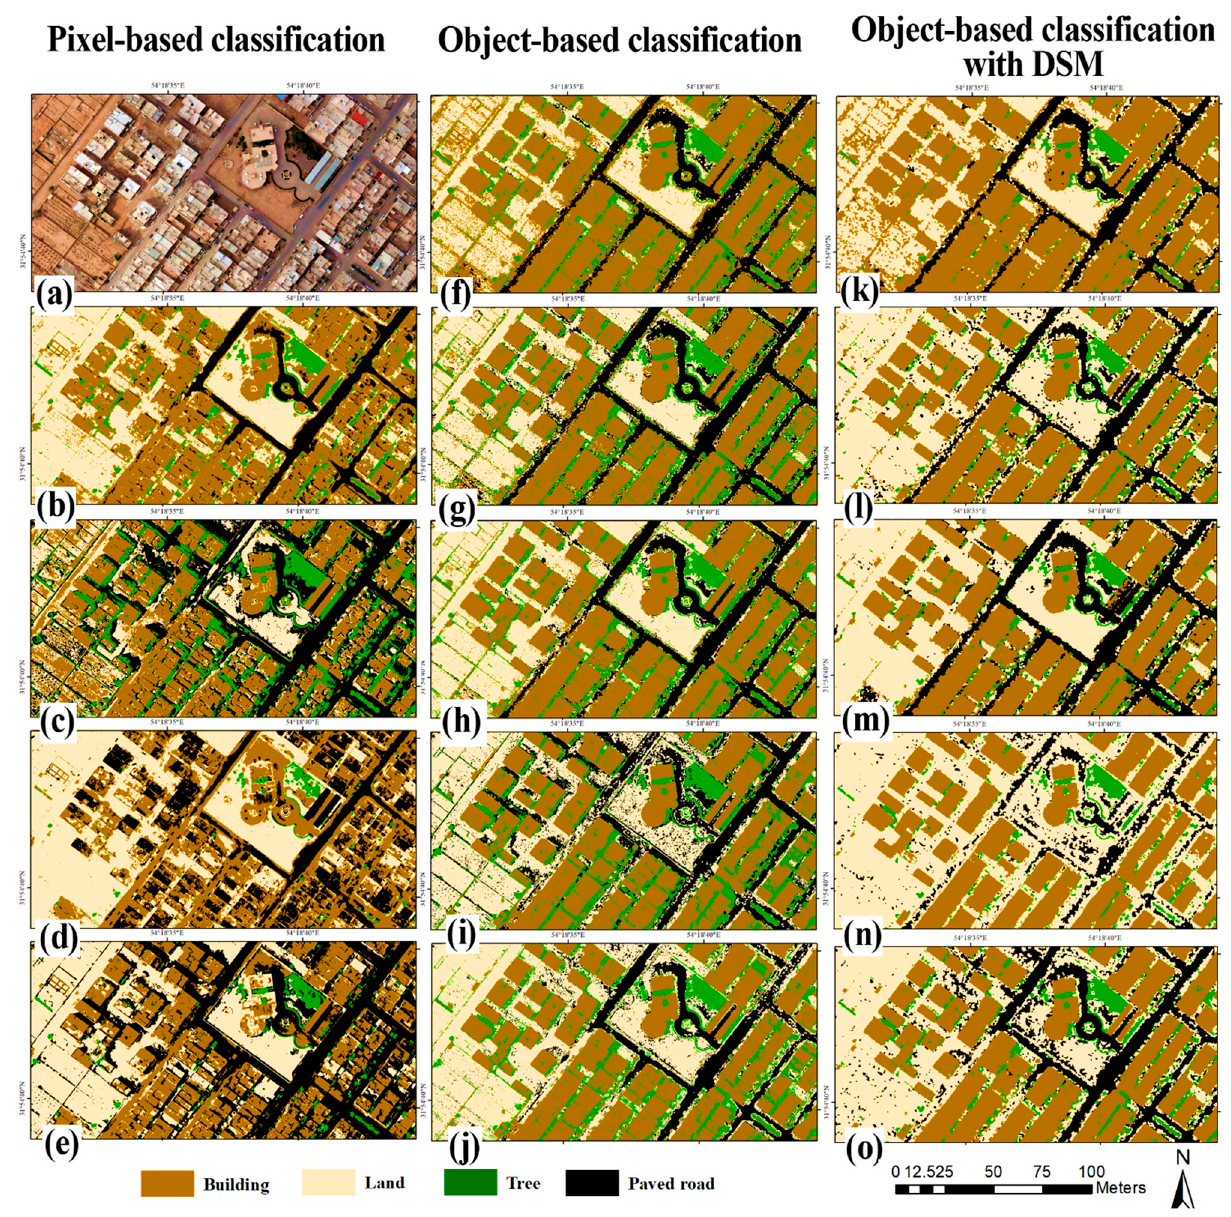
Figure 3. Classification of unmanned aerial vehicle (UAV) images obtained using: (1) pixel-based methods ( a ) UAV image, ( b ) maximum likelihood method, ( c ) minimum distance method, ( d ) spectral angle mapping (SAM) and ( e ) Mahalanobis method; (2) object-based methods ( f ) Bayes method, ( g ) support vector machine (SVM), ( h ) K-nearest-neighbor (KNN), ( i ) decision tree (DT) and ( j ) ran- dom forest (RF); (3) object-based methods using the digital spatial model (DSM) ( k ) Bayes, ( l ) SVM, ( m ) KNN, ( n ) DT and ( o ) RF.